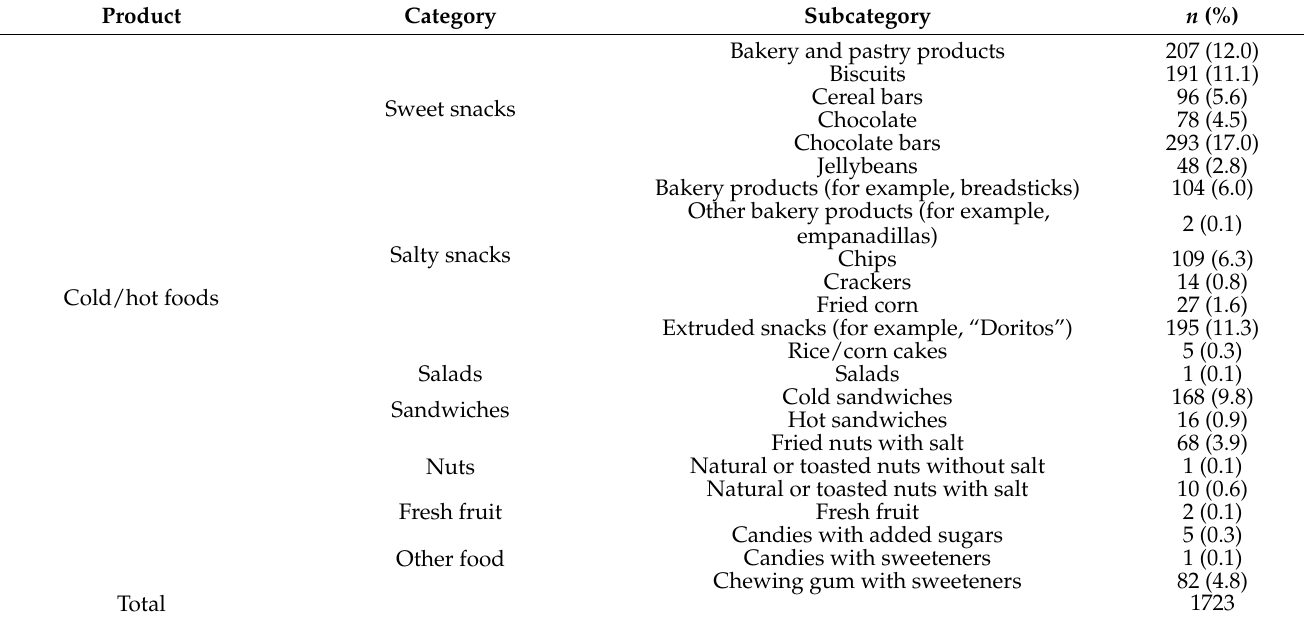
Table 1. Numbers of food and drink products by category and